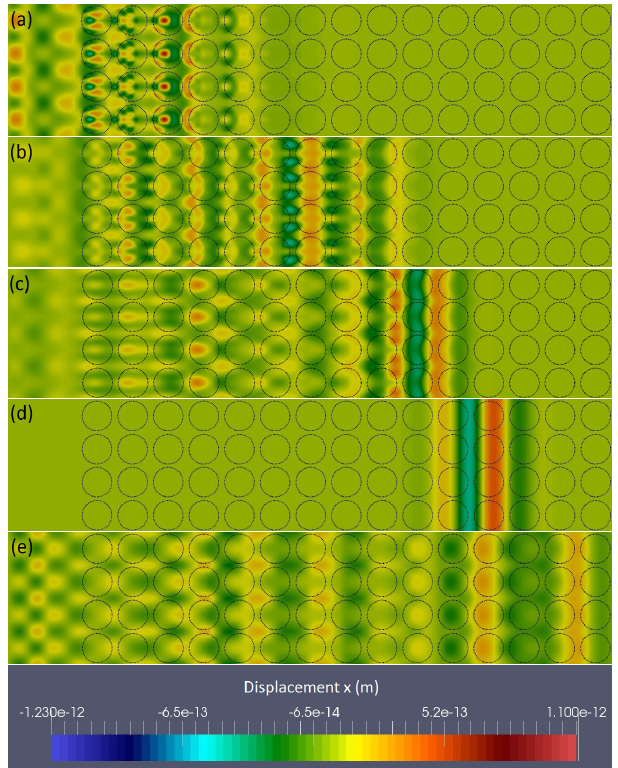
Figure 8. Snapshots of 5 cases at the same time ( t = 1.27171 × 10 − 11 s) with ω = 5 THz and r = 25 Å (dashed cirles indicate the positions of the inclusions) ( a ) E i / E m = 0.2 ( b ) E i / E m = 0.4 ( c ) E i / E m = 0.6 ( d ) E i / E m = 1.0 ( e ) E i / E m =